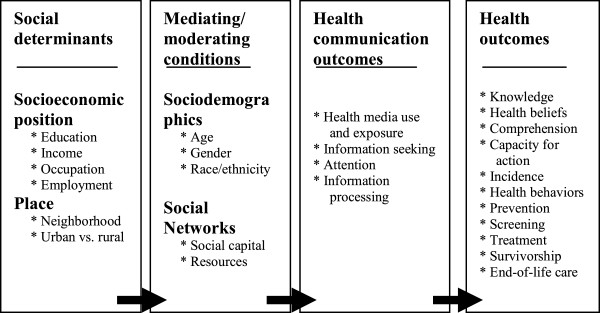
Structural influence model (Viswanath et al. [15]).